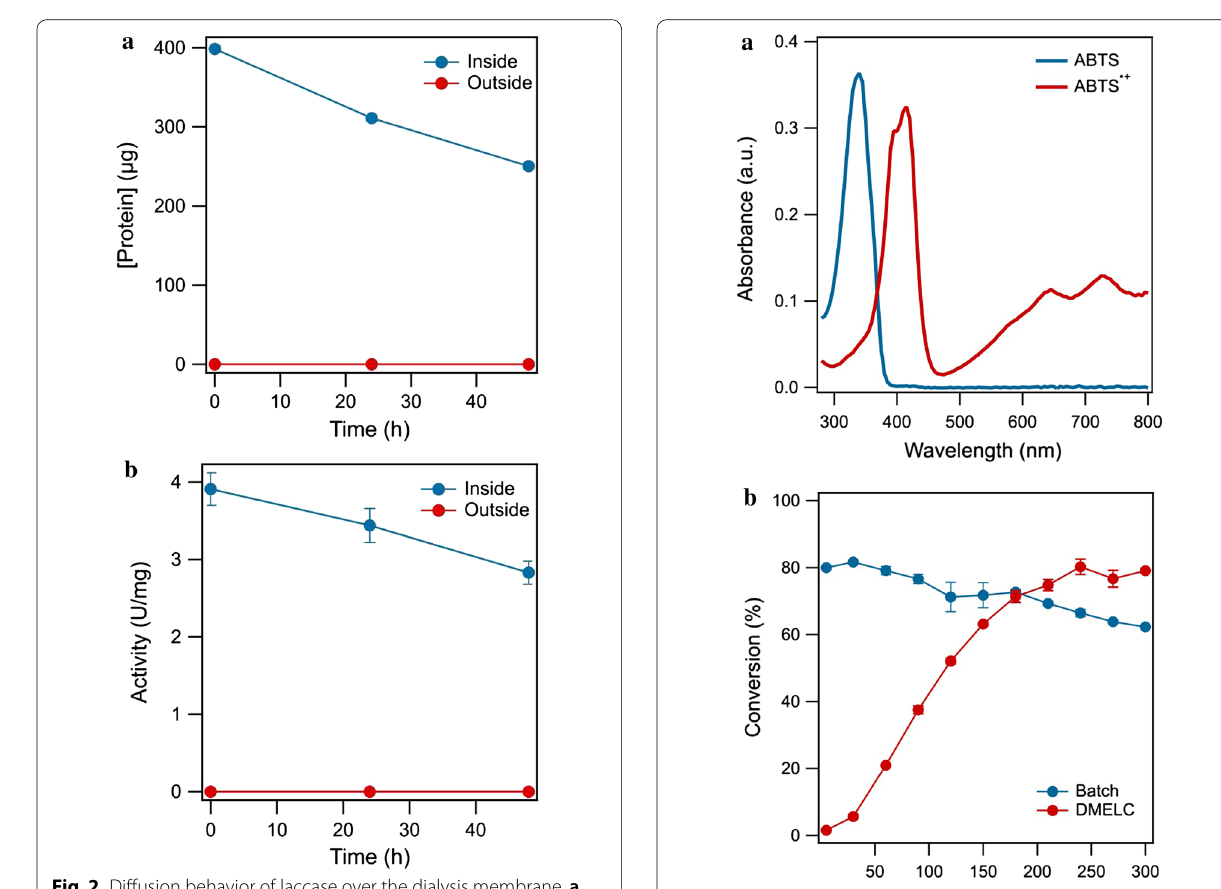
Fig. 2 Diffusion behavior of laccase over the dialysis membrane, a protein and b laccase activity (temperature, 30 °C, shaking speed, 180 rpm, pH, 5.8, 2.0 mg laccase weight)